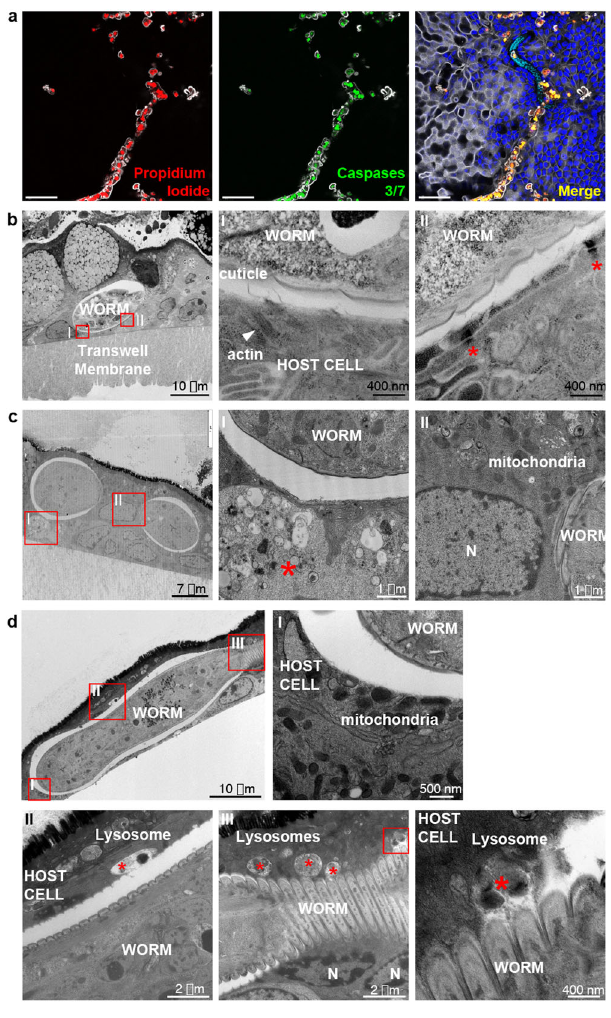
Fig. 6 Close interactions between T. muris whipworm larvae and IECs at syncytial tunnels during early infection of caecaloids. a Selected confocal IF 2D images from a z-stack showing IECs left behind in the tunnel are necrotic (propidium iodide (red) and caspase-3/7 (green) positive), while IECs infected by worm are alive after 72 h p.i. In blue and aqua, DAPI stains nuclei of IECs and larvae, respectively; and in white, phalloidin binds to F-actin. Scale bars 50 μ m. b – d Representative TEM images of transverse sections of caecaloids infected with T. muris L1 larvae, showing host- parasite interactions during early infection: b Host cell actin fi bres (white arrowhead) surround the cuticle of the worm (inset I) and desmosomes (red asterisks) are still present (inset II) at 24 h p.i. c Lique fi ed cell (inset I, asterisk), and nuclei in early stages of apoptosis (inset II) at 72 h p.i. d Displaced mitochondria (inset I) and numerous lysosomes in host cells, some actively discharging over the worm cuticle (insets II and III). N, nuclei; red asterisks, lysosomes. TEM images are representative of 10 larvae during the fi rst 72 h of infection. Imaging experiments on T. muris- infected caecaloids were done in triplicate across more than ten independent replicas using three caecaloid lines derived from three C57BL/6